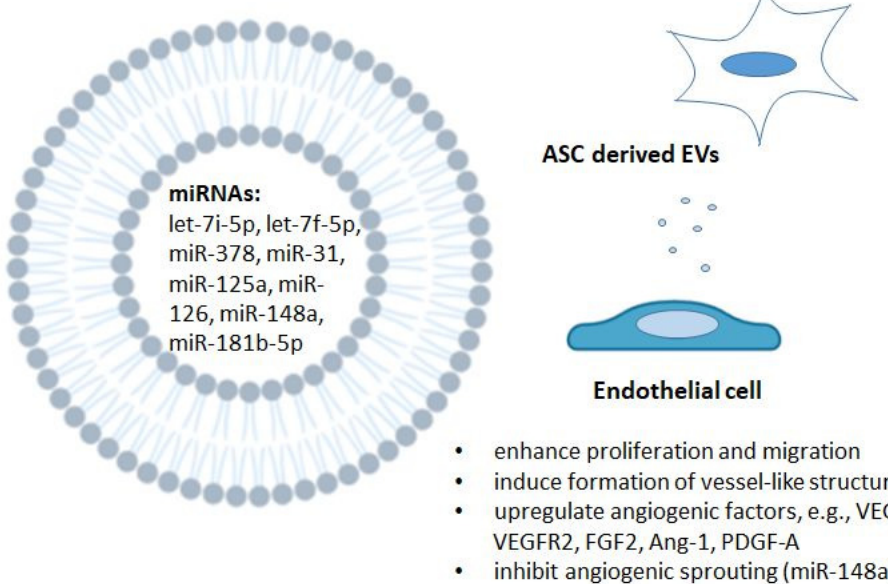
Figure 4. The miRNA cargo of ASC-EVs known to have effects on endothelial cells. Figure created using BioRender.